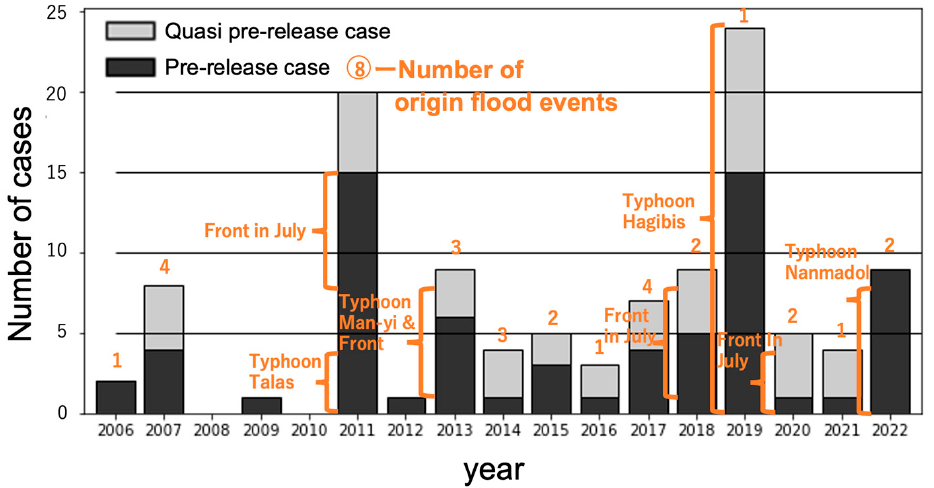
Figure 12. Number of pre-release cases (black) and quasi-pre-release cases (gray) per year. Number of origin events and major event names are added in orange.